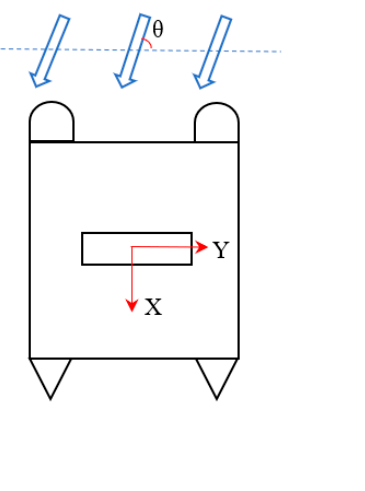
Figure 15. ( a ) Top view of platform affected by waves. ( b ) The maximum amplitude of the six- degree-of-freedom motion of the platform in the basin test under regular wave conditions, β = 180°, 225° and 270°, T = 9 s, and H = 15 m.